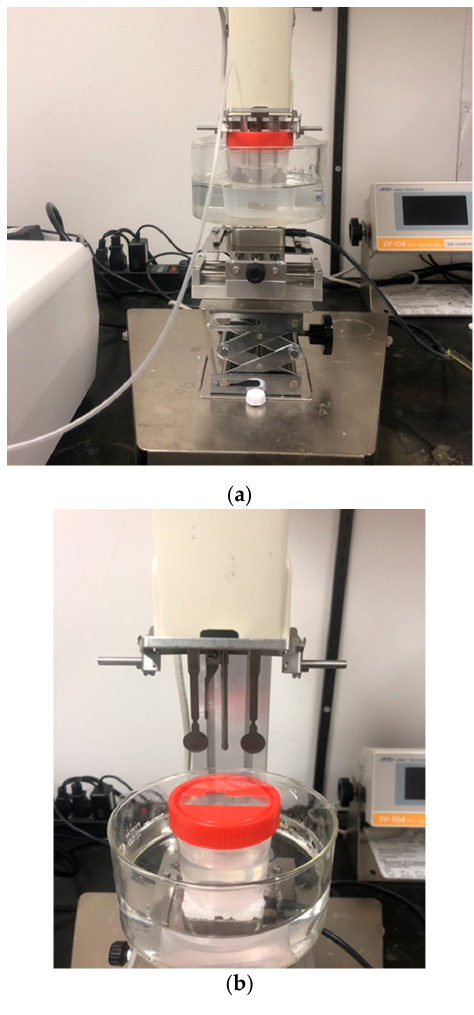
Figure 5. ( a ) Experimental set-up used for testing the continuous process for collapse-point deter- mination and for measuring the collapse point of CUP polymer; ( b ) picture of tuning forks on the vibration viscometer.